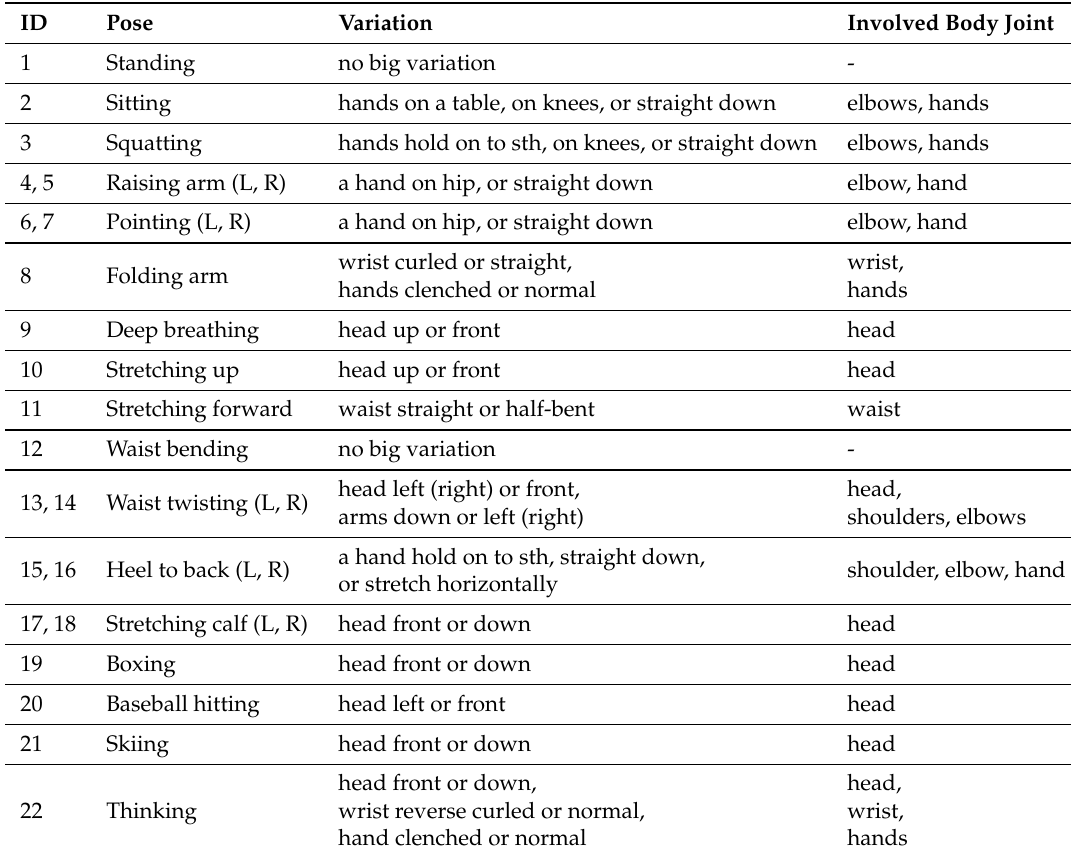
Figure 2. Poses in HDPoseDS. The numbers under the figures correspond to the numbers in Table 1. Table 1. Intra-class variation observed in data collection. Poses are sometimes represented in slightly different manner depending on the subjects. L and R in the pose names means Left and